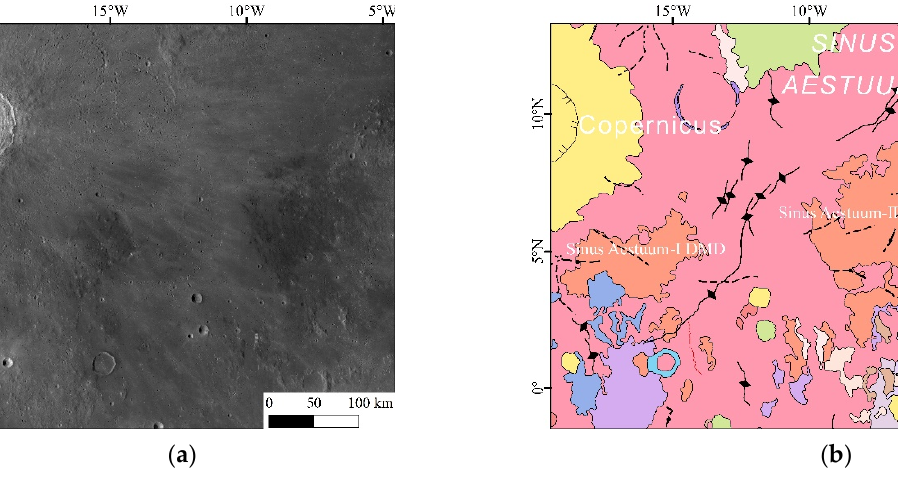
Figure 14. Aestuum Ⅰ DMD and the Sinus Aestuum- Ⅱ DMD. ( a ) Aestuum Ⅰ DMD and the Sinus Figure 14. Aestuum I DMD and the Sinus Aestuum-II DMD. ( a ) Aestuum I DMD and the Sinus Aestuum- Ⅱ DMD on the LROC WAC Global Morphology Mosaic; ( b ) Geology of the Aestuum Ⅰ Aestuum-II DMD on the LROC WAC Global Morphology Mosaic; ( b ) Geology of the Aestuum I DMD and the Sinus Aestuum- Ⅱ DMD. DMD and the Sinus Aestuum-II